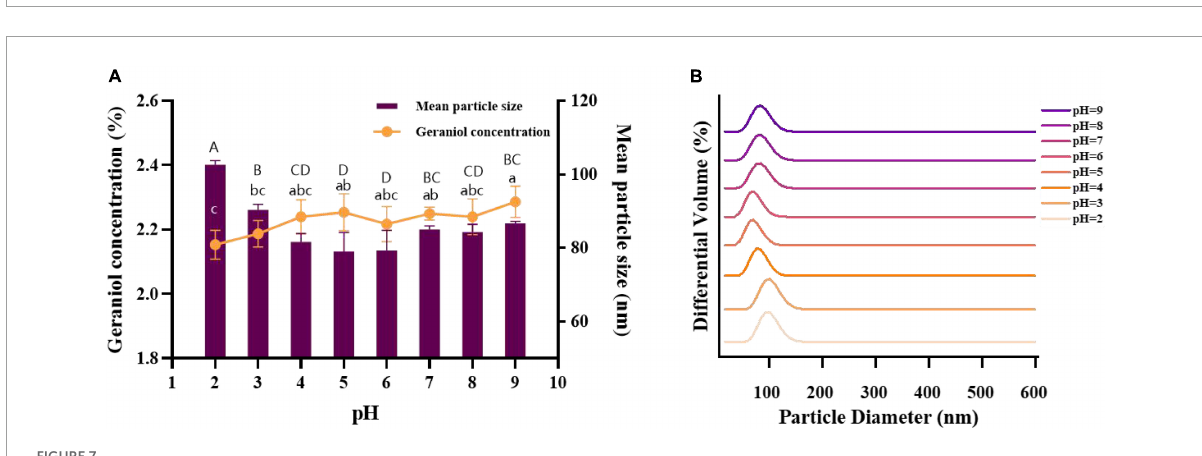
FIGURE7 Effect of different pH on the mean particle size (A) , geraniol content (A) and particle size distribution (B) of G-NE. (Different capital (lowercase) letters indicate significant intra-group variability, p < 0.05 ; identical capital (lowercase) letters indicate significant inter-group variability, p > 0.05